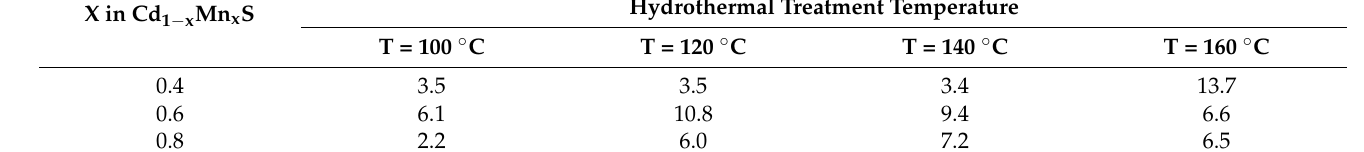
Table 2. The rate of hydrogen evolution in dependence on the parameter x in Cd 1 − x Mn x S and the temperature of hydrothermal treatment. Experimental conditions: C 0 (Na 2 S/Na 2 SO 3 ) = 0.1/0.1 M, m cat = 50 mg, V susp = 100 mL, and λ = 425 nm.